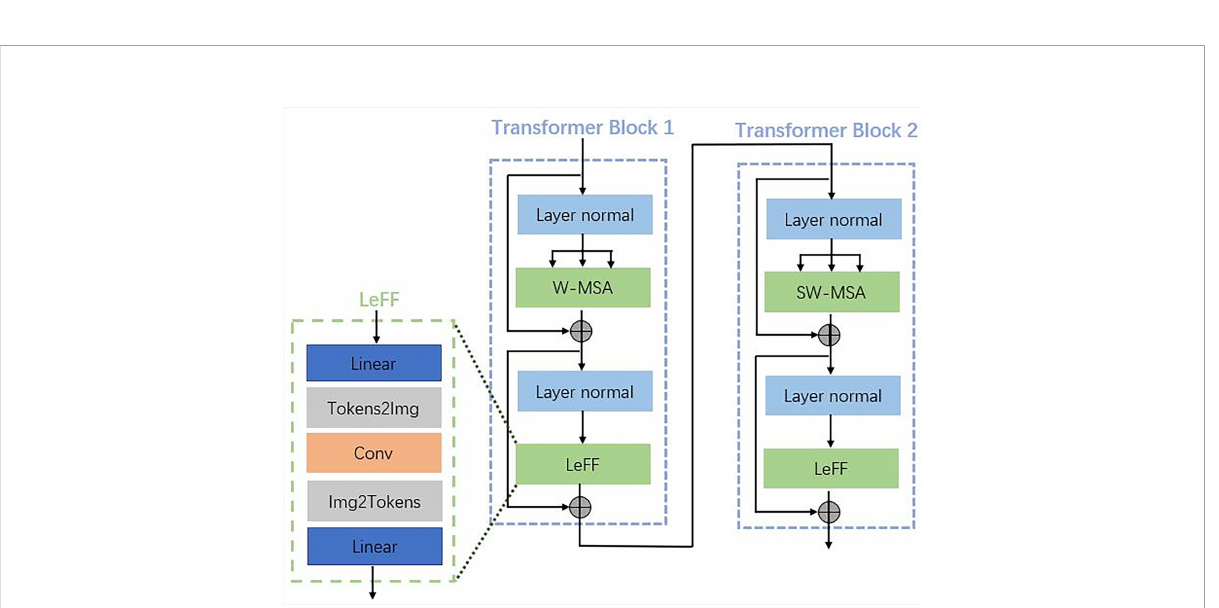
locally enhanced feedforward network (LeFF) layer, as shown in Figure 3. Instead of using global self-attention on the whole image, we implemented self-attention within non-overlapping local windows to reduce the computational cost, the window- based MSA (W-MSA). For the 2D feature maps X ∈ R C × H × W with H and W as the height and width of the maps, we split X into non-overlapping windows with a window size of M × M. Then, we obtained the fl attened and transposed features X i ∈ R M 2 × C from each window i . Next, we performed self-